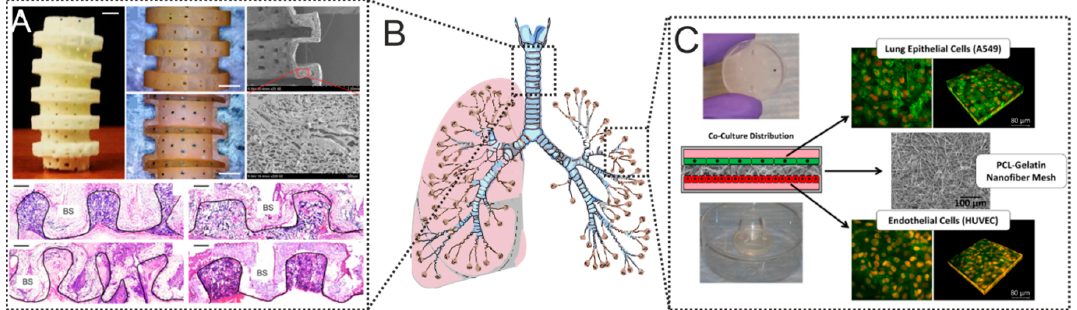
Figure 4. ( A ) Image of a tracheal implant (appearance and section). SEM micrograph of the outer wall and slice. Scalebar 2 mm. Histological Section 8 weeks after implantation. Reprinted with permission from Elsevier, 2015 [8]. ( B ) Schematics showing lungs, where 3D printed scaffolds shown in ( A ) can be incorporated, and which can be modeled by microfluidic devices depicted in ( C ). ( C ) Schematics of the co-culture system and images of assembled fluidic devices with cells including confocal laser scanning images of epithelial and endothelial cells co-cultured on a 75/25 (PCL/gelatin) fiber mesh. Reprinted from [173] with permission from Nature Publishing Group, © 2017.